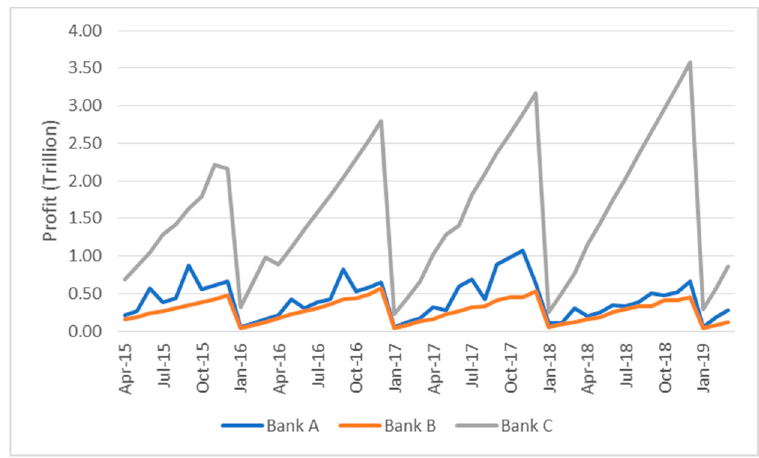
Figure A3. Reported operational profit of Banks A, B and C.